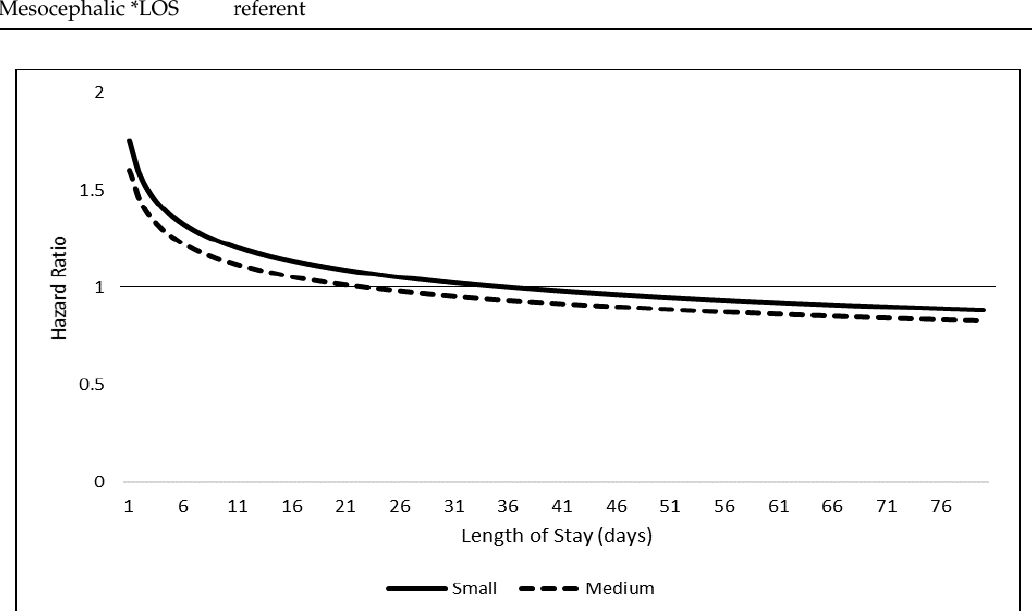
Figure 1. Model adjusted age group by length of stay interaction displayed as hazard ratios, estimated from the simple random sample of 4500 dogs, compared to the referent adult group.